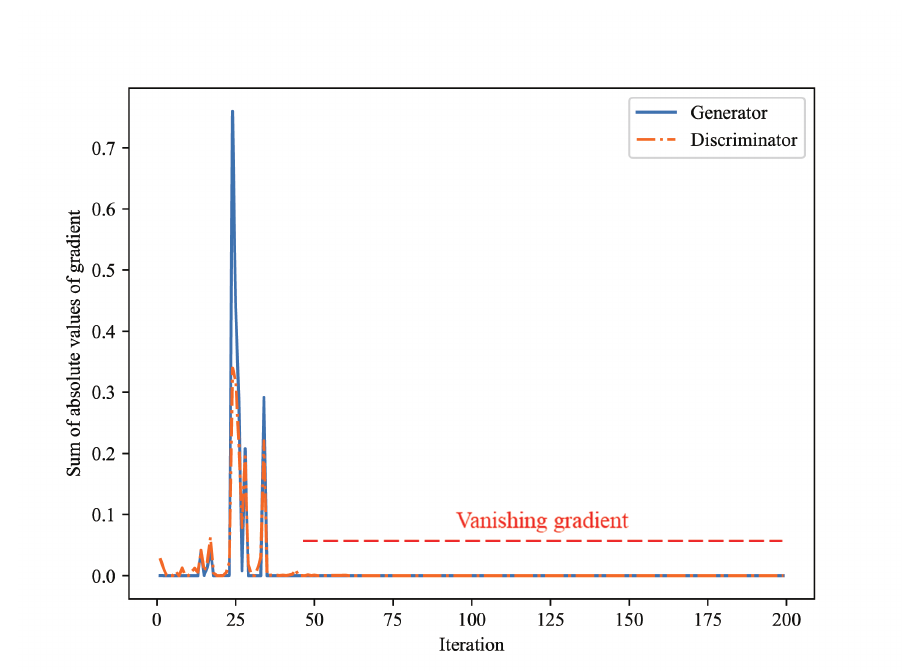
Figure 1. Vanishing gradient phenomenon that artificially occurs when a generator is trained using a well-trained discriminator of GAN. After about 50 iterations, the gradient of the generator